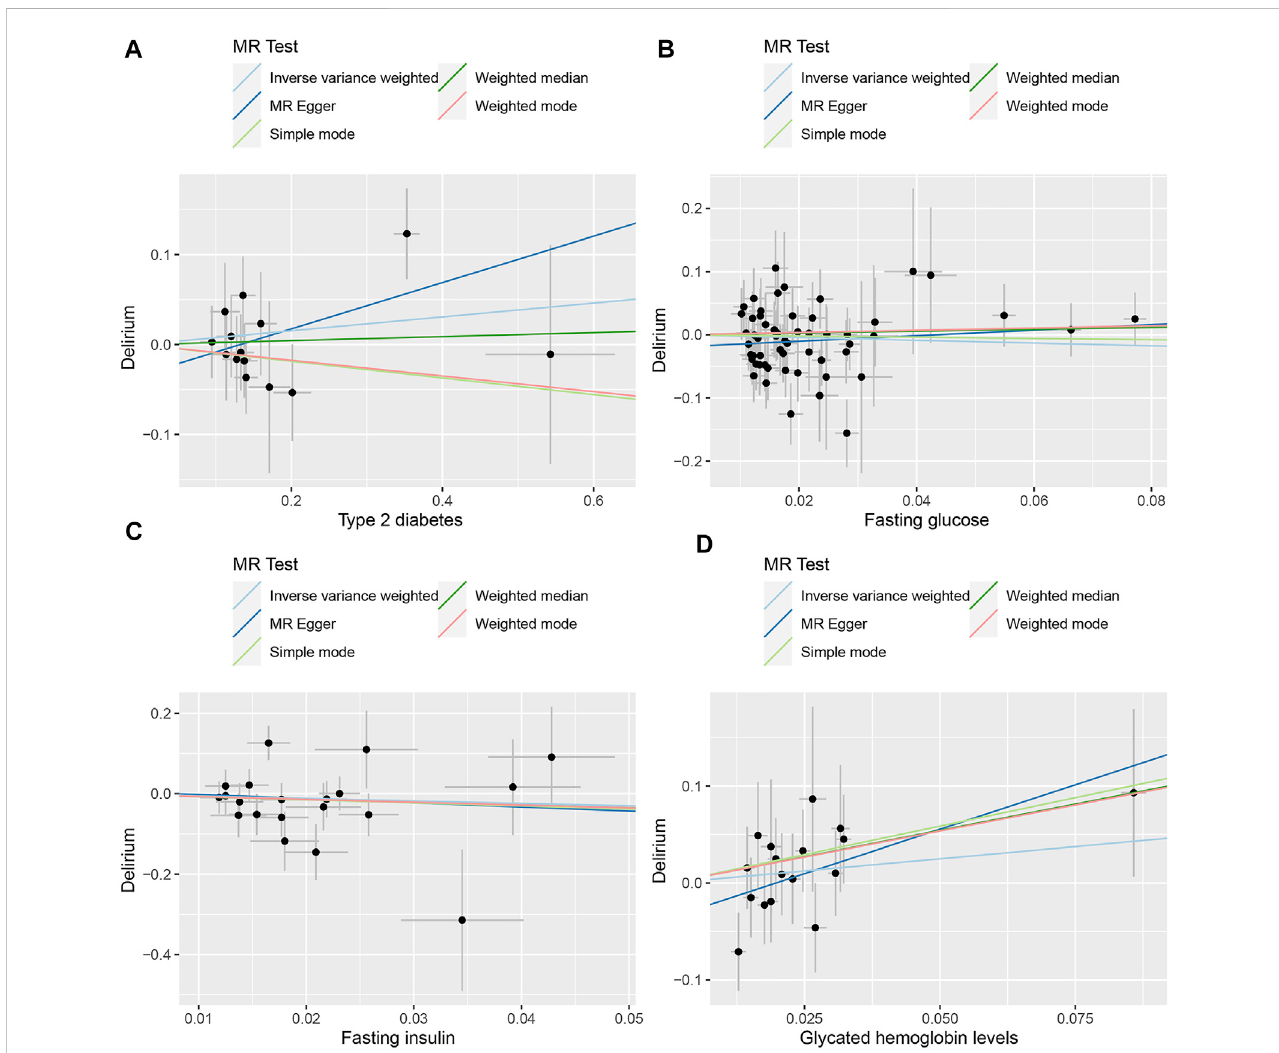
FIGURE 2 Scatter plot of the MR results between exposures and outcome. (A) T2D and delirium. (B) FG and delirium. (C) FI and delirium. (D) HbA1c and delirium.